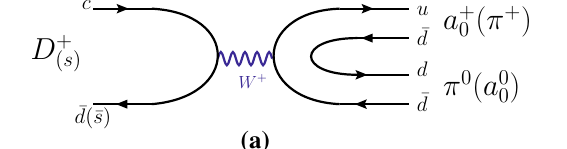
→ a + π 0 , a 0 π + via the W -annihilation diagrams 0 0 s )